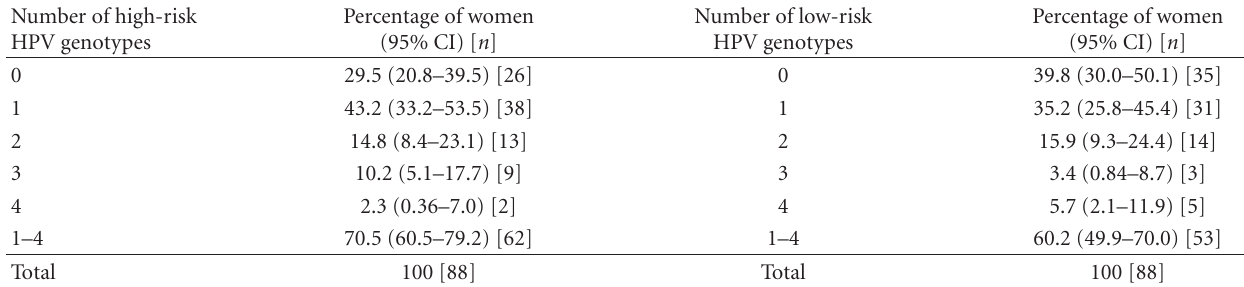
Table 2: Distribution of the number of human papillomavirus (HPV) genotypes among HIV-negative